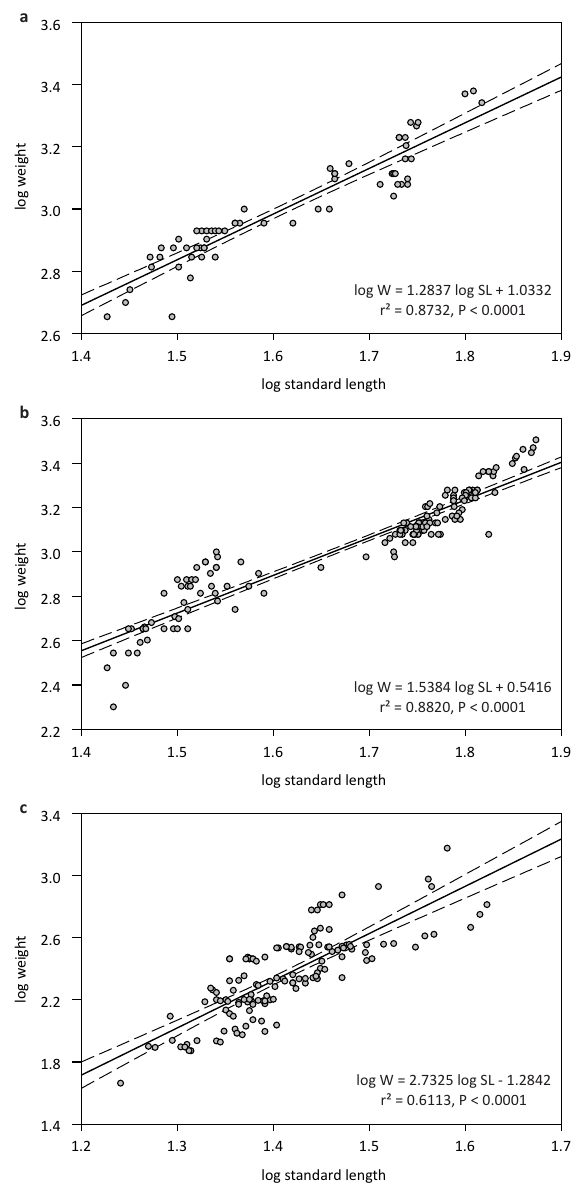
Figure 1. Standard length versus weight relationship of (a) Channa diplogramma , (b) Channa marulius and (c) Channa striata . Dashed lines indicate 95% confidence interval for the regression line.